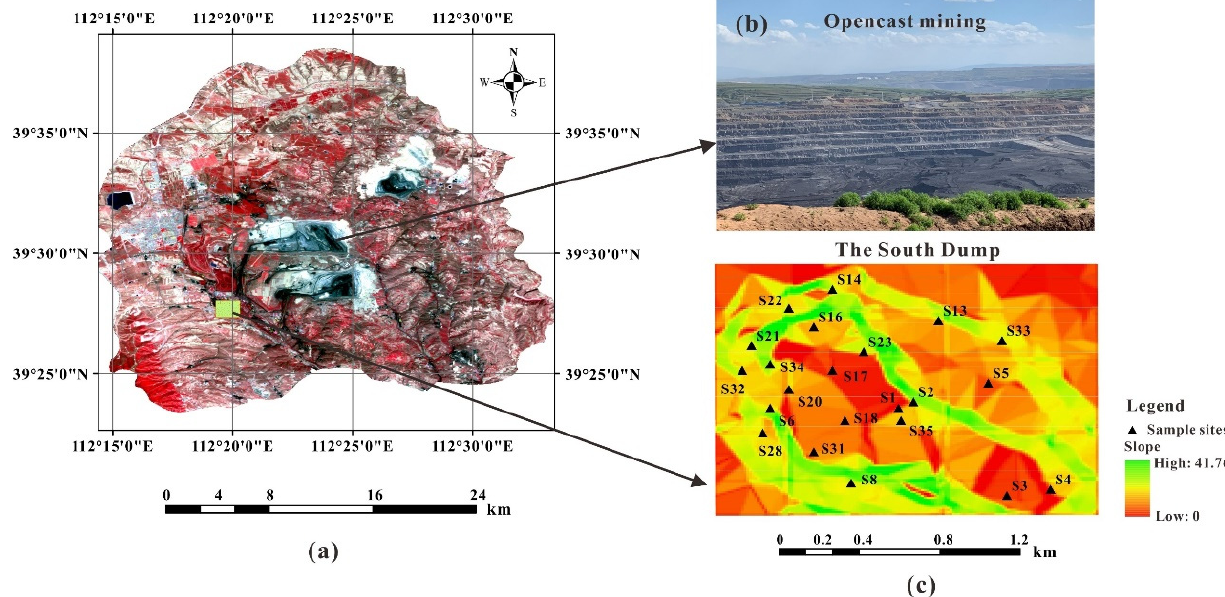
Figure 1. Location of Pingshuo opencast coalmine ( a ), current conditions of opencast mining ( b ), and slope characteristics across the South Dump ( c ).